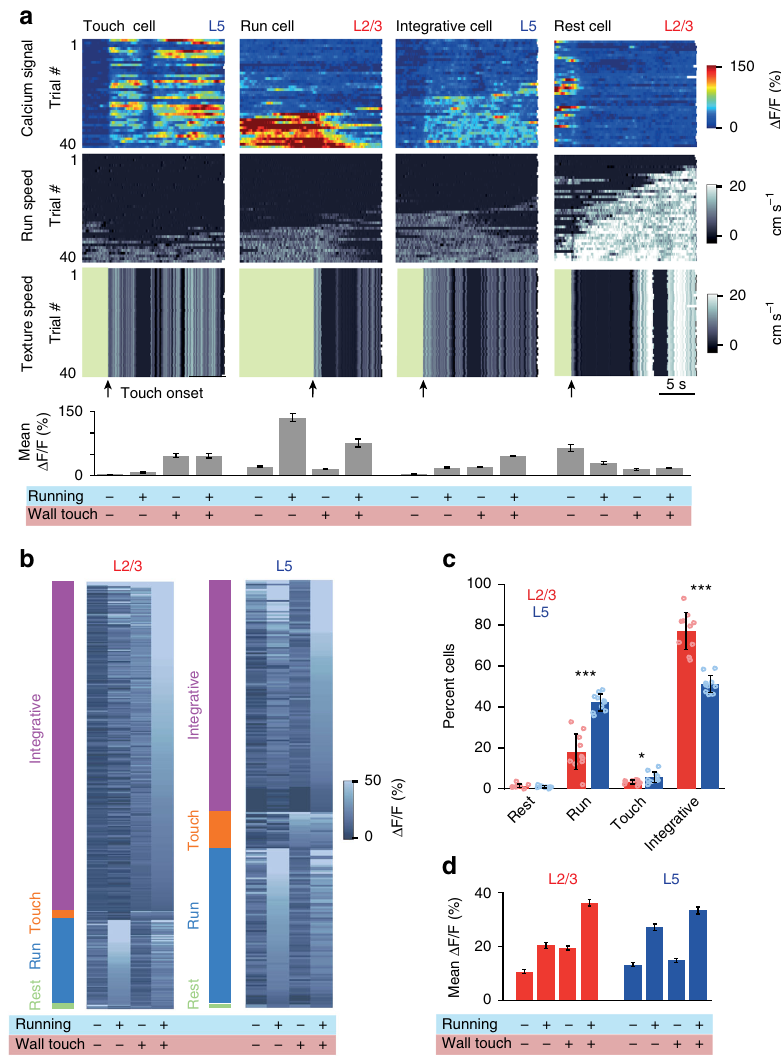
Fig. 6 A higher fraction of neurons integrate locomotion and concurrent wall touch in L2/3 compared with L5. a Four example neurons with different response properties recorded during Open-loop stimulation. Each column presents data from a single neuron across trials in a single session. Top panel heat map shows Δ F / F calcium signal with each row representing a trial. Trials are sorted according to the mean run speed of a trial. Middle and bottom panels show the run speed and texture-rotation speed of corresponding trials. Green periods in the bottom panel indicate when the texture was not in contact with whiskers. Bar graphs at the bottom are mean Δ F / F activity during the four stimulus and movement conditions: no-touch/no-running, running/ no-touch, touch/no-running, and touch/running. b Categorization of all L2/3 ( n = 338, 5 mice) and L5 ( n = 236, 4 mice) neurons according to their activity during their fi rst Open-loop session. Color bars on the left show categories, gray scale shading shows mean Δ F / F at four stimulus/behavior conditions. Cells are sorted according to their mean activity during ‘ running/wall touch ’ condition relevant to their assigned category. c Normalized distributions of four response categories in L2/3 and L5 populations. Means and standard deviations are calculated from 10 random selections of 11 sessions out of total 24 recording sessions. (Two-sampled T-test is performed to compare distributions for each category p rest = 0.2, p run = 5.7 × 10 − 7 , p touch = 0.02, p = 3.7 × 10 − 7 .) d Average population responses for the four stimulus/movement conditions for L2/3 (in red) and L5 (in blue) neurons shown integrative in ( b ) (mean Δ F / F ±